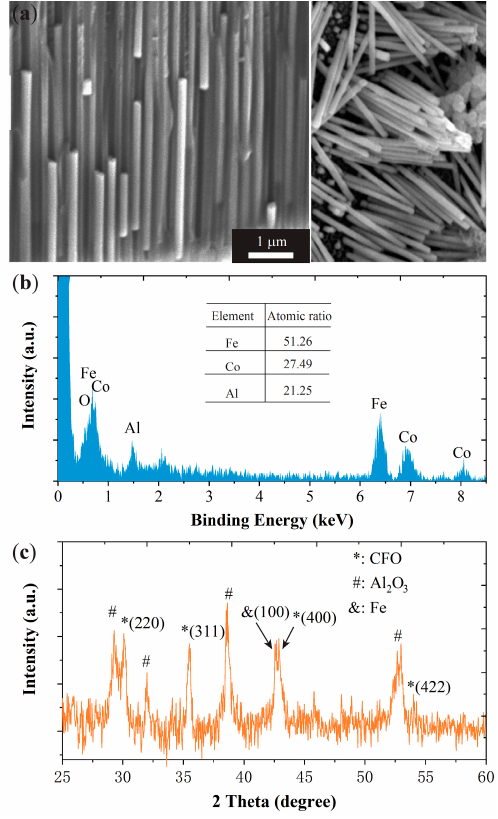
Figure 10. Morphology and crystal structure of the prepared CFO nanowires, ( a ) SEM images; ( b ) EDS spectrum; and ( c ) XRD pattern.